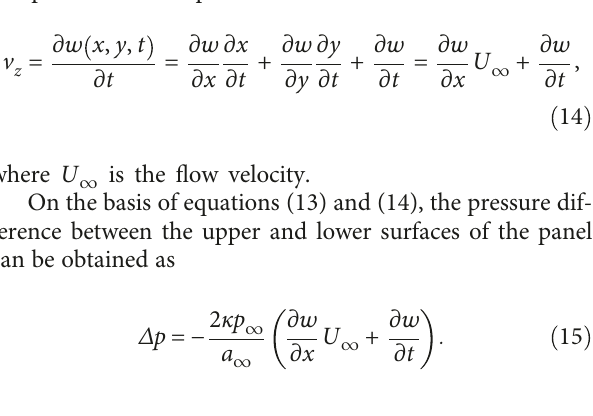
Figure 3: The 1st, 2nd, 3rd, and 5th frequencies of the C-C-C-C panel with di ff erent